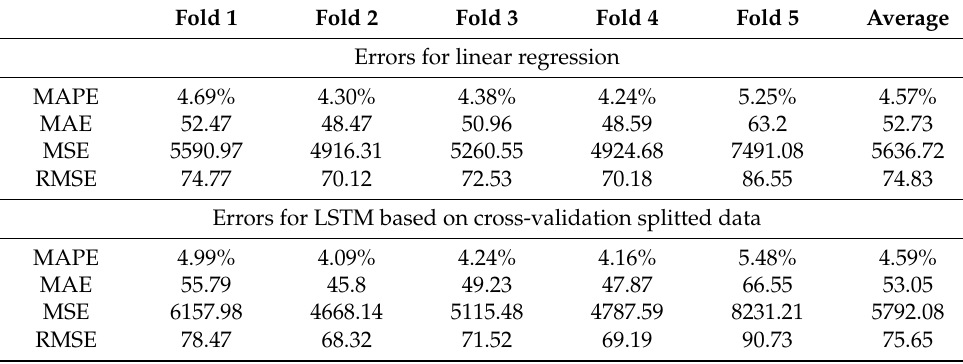
Table 2. Forecasting metrics for the second